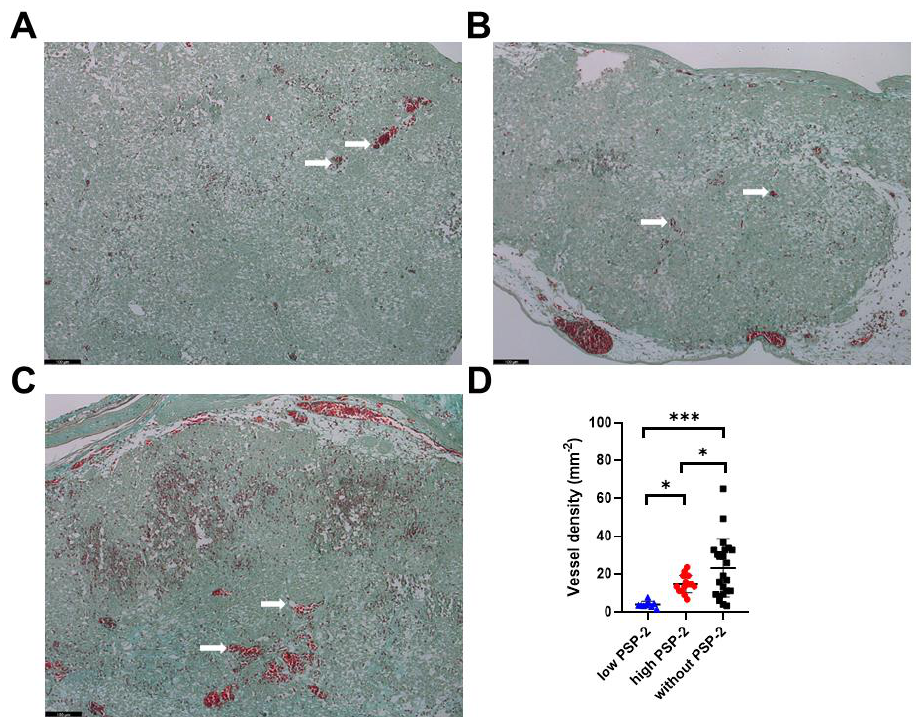
Figure 3. Vessel density of H460 tumors grown for 1 week on the CAM assay. Histological sections stained with Masson Goldner Trichrome for groups with low-dose PSP-2 ( A ) and high-dose PSP-2 ( B ) and without PSP-2 ( C ). Scale bars are 100 µm. White arrows indicate vessels. Vessel density ( D ) shown with mean and standard deviation. One-way ANOVA was computed and pairwise comparison probabilities p were calculated using the Fisher’s PLSD post hoc test, with p < 0.05 as significance level. Key: p < 0.05 (*) and p < 0.001 (***).